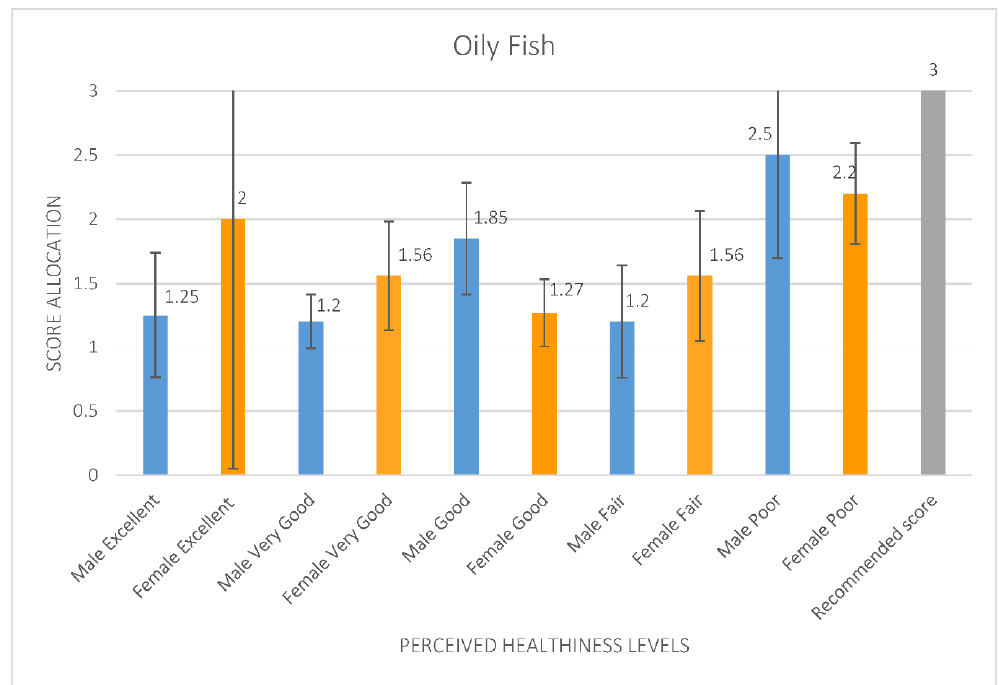
Figure 4. Mean oily fish score allocation from the Short Form FFQ evaluated using DANTE tool per perceived healthiness levels for all older adolescents compared to the recommended oily fish food group score.